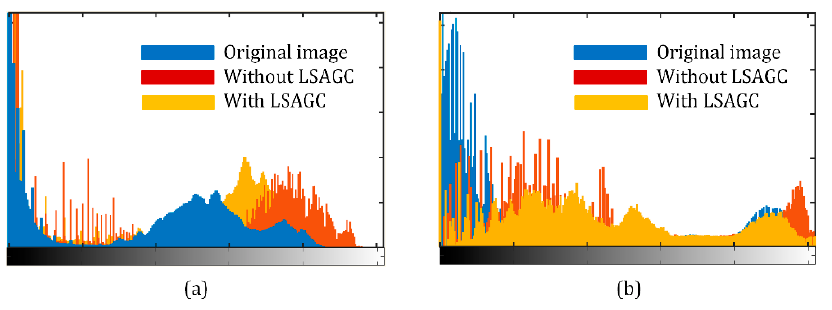
Figure 11. Histogram analysis: ( a ) images from Figure 10a–c; ( b ) images in Figure 10d–f.